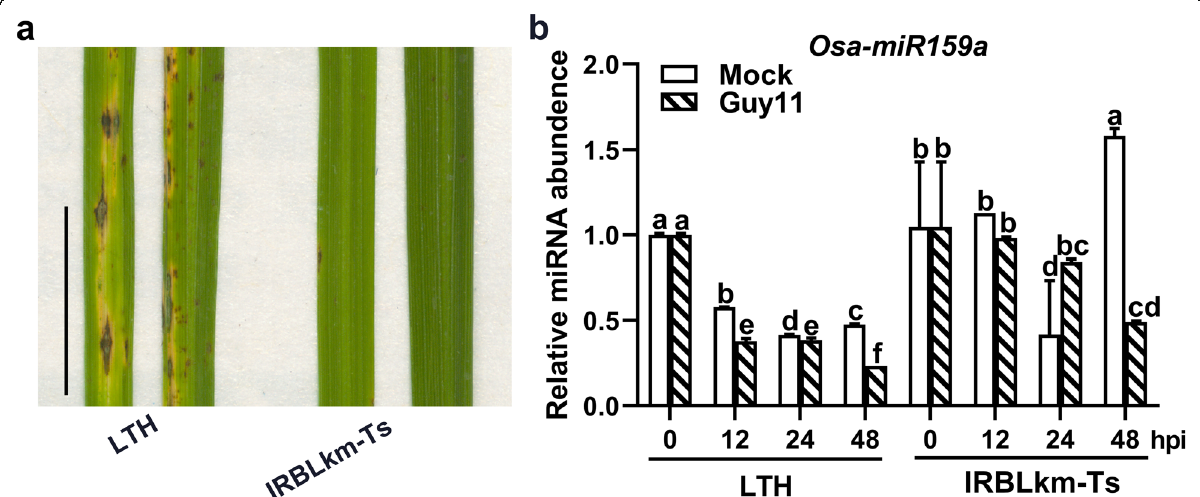
Fig. 1 Osa-miR159a is differentially responsive to Magnaporthe oryzae in the susceptible and resistant accessions. a Representative leaves show the blast disease phenotype at 5 days post-inoculation (dpi) with M. oryzae strain Guy11 in LTH and IRBLkm-Ts. Scale bars, 10 mm. b Reverse transcription-quantitative PCR (RT-qPCR) shows the accumulation of Osa-miR159a in LTH and IRBLkm-Ts upon M. oryzae or mock treatment at the indicated time points. Error bars indicate SD ( n = 3). Different letters above bars indicate significant differences ( P < 0.05) as determined by a one- way ANOVA followed by Tukey ’ s HSD post hoc test. This experiment was repeated two times with similar